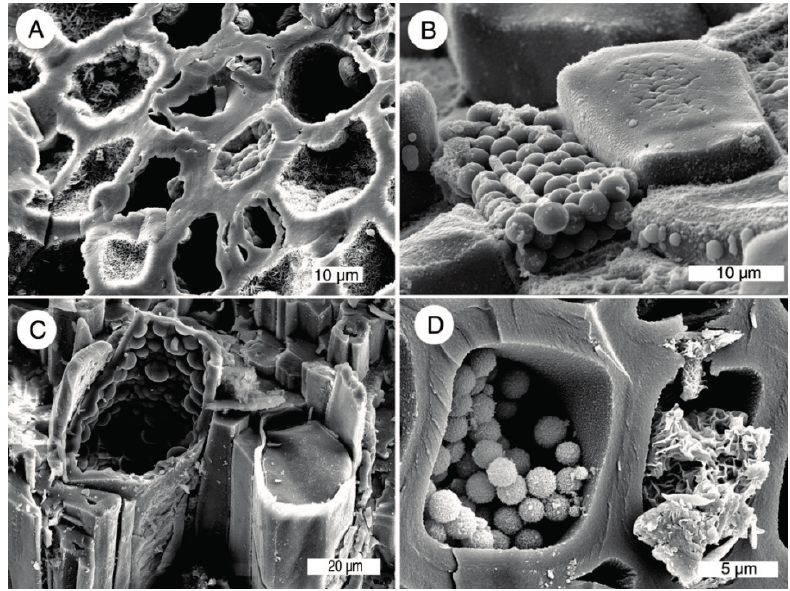
Figure 14. Cell-by-cell variability in mineralization. ( A ) Opal-Ct, transverse view, showing individual cells with botryoidal linings, continuous microcrystalline coatings, and microcrystalline hemispheres, locality 2 (Cessily-Ann opal mine); ( B ) Opal-CT, transverse views of adjacent tracheids mineralized with packed lepispheres and with solid opal. Locality 2 (Cessily-Ann opal mine); ( C ) Opal-A, tracheid containing botryoidal lining adjacent to tracheid with solid filling, locality 14; ( D ) Transverse view of carbonized cells (identified because of strong C peaks and no Si peaks in SEM.EDS spectra). One cell is partially filled with loosely-packed opal-CT lepispheres; the adjacent cell contains crinkly clay minerals, locality 2 (Royal Peacock opal